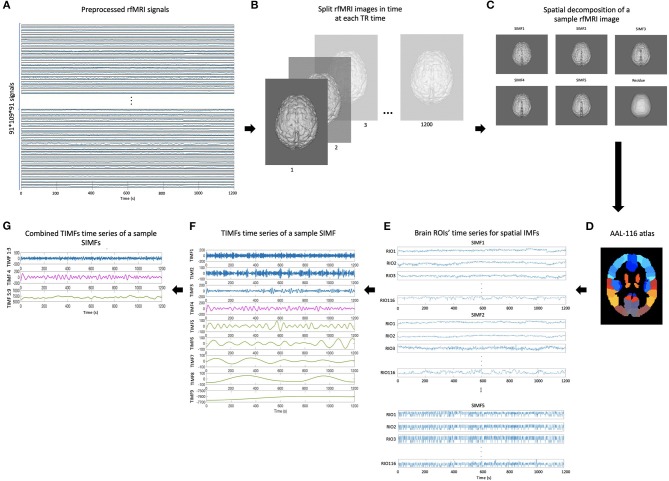
Pipeline for computing spatial and temporal IMFs (SIMF and TIMF) of the fMRI data. (A) A sample of fMRI data. (B) Splitting each fMRI data in time at each TR time. (C) SIMFs at each TR time which are computed by applying FATEMD approach. (D) Shows the AAL 116 atlas used after merging SIMFs in time to select the peak voxel of each region. (E) Time series of all brain ROIs for each SIMF. (F) The TIMFs' time series of a sample SIMF for one ROI computed by using ICEEMDAN approach. (G) Summation of time series of the TIMFs in (F) based on frequency bands of slow1 to slow5 defined in the literature. The summation of the TIMF1 to TIMF3, TIMF4, and the combination of TIMF5 to TIMF9 are labeled as TIMF1, TIMF2, and TIMF3 in the rest of the paper, respectively. rfMRI, resting-state fMRI; TIMF, Temporal Intrinsic Mode Function; SIMF, Spatial Intrinsic Mode Function; ICEEMDAN, Improved Complete Ensemble Empirical Mode Decomposition with Adaptive Noise; FATEMD, Fast and Adaptive Empirical Mode Decomposition; ROI, Region of Interest.